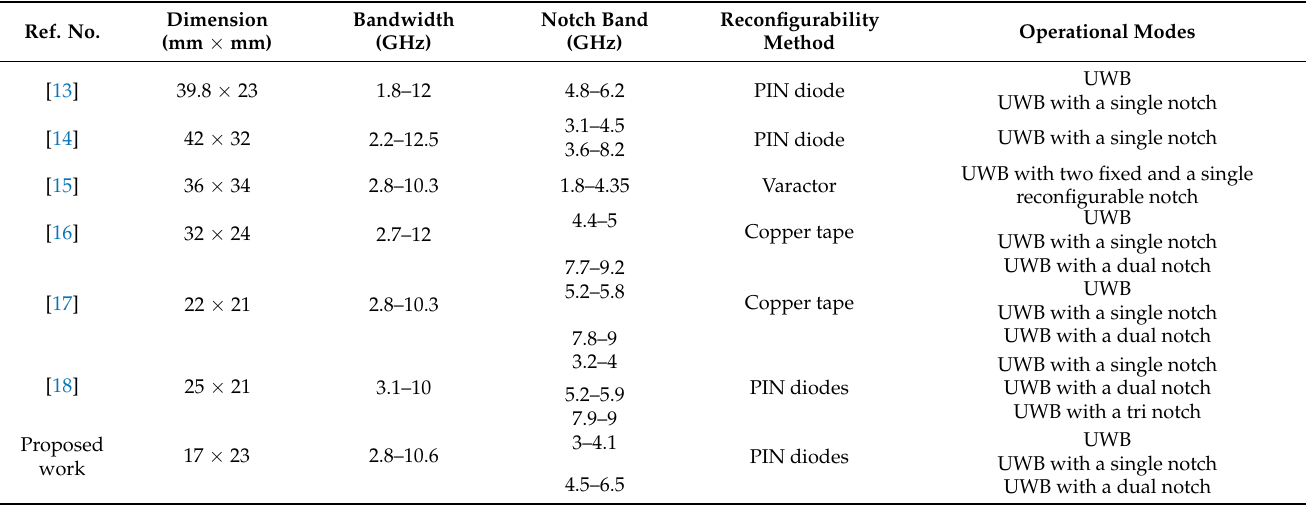
Table 1. Analysis of the proposed reconfigurable notched UWB antenna in comparison to cutting- edge